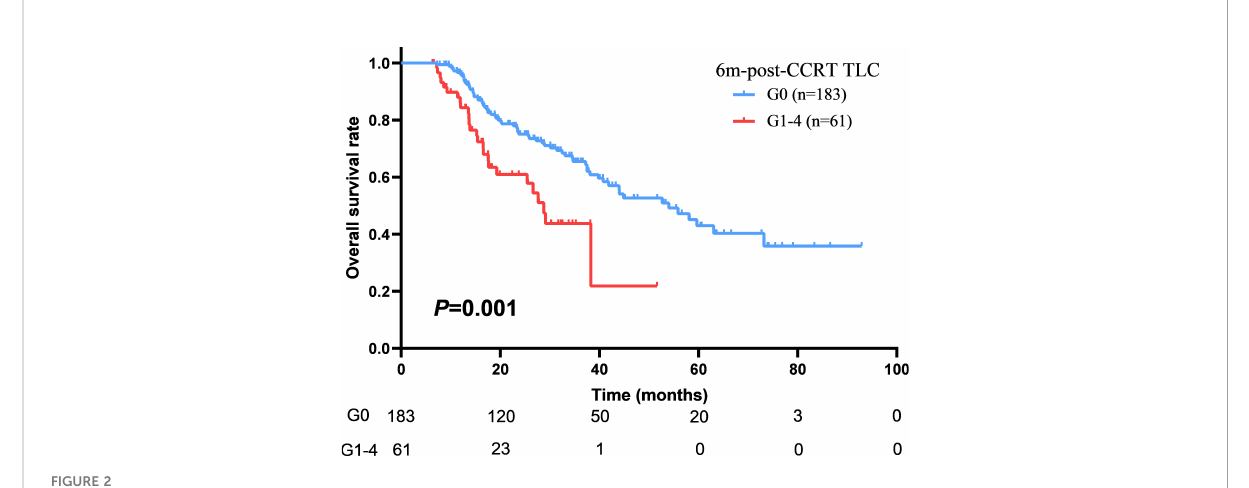
FIGURE 2 The association between overall survival (OS) and 6m-post-CCRT